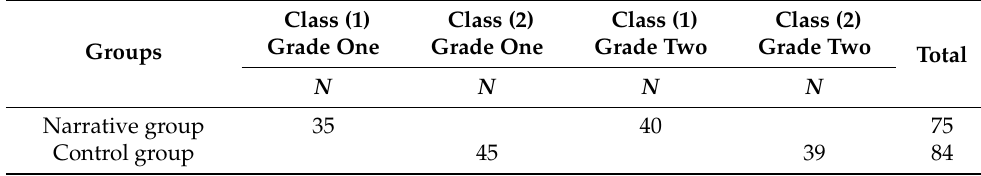
Table 3. Composition of participants ( N = 159).